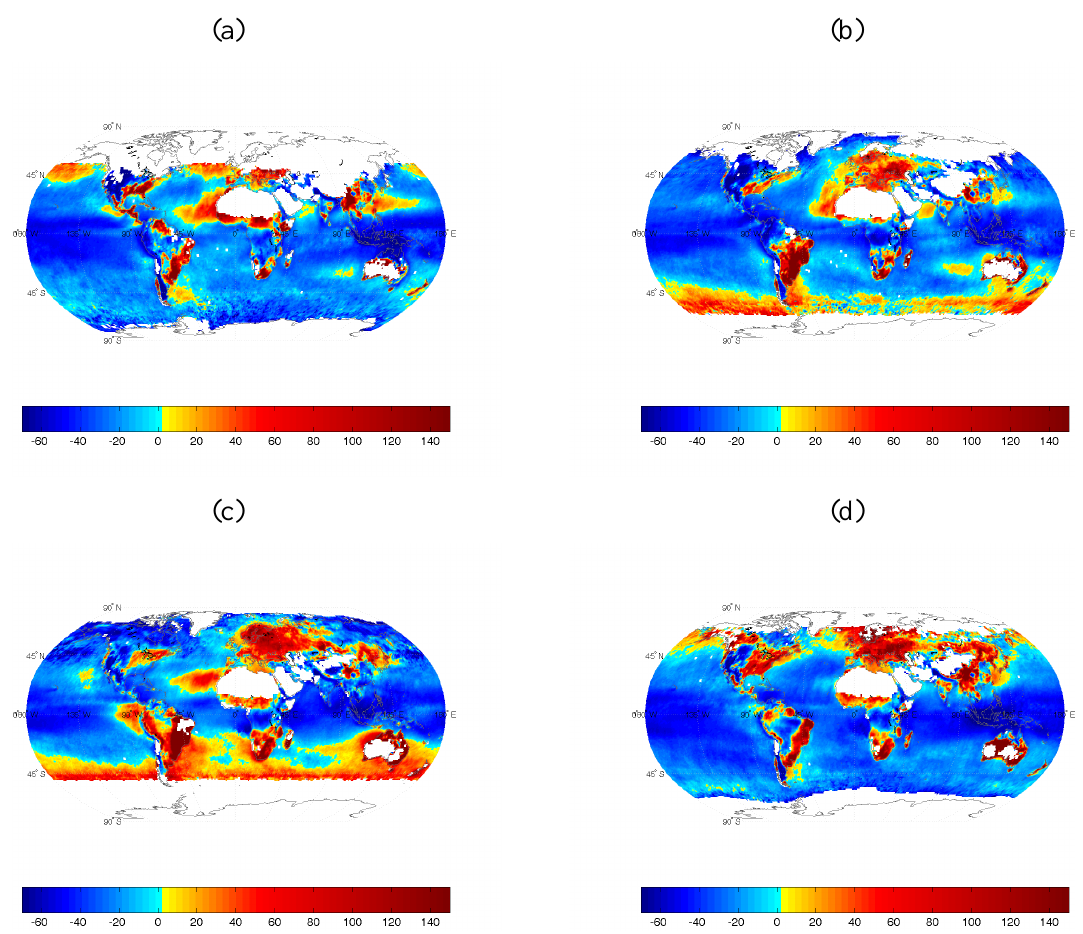
Fig. 2. Comparison between HAC and MODIS (03/2000–02/2007) total aerosol optical depth at 550nm. Global seasonal distribution of relative percentage differences ((HAC − MODIS)/MODIS – %) for (a) winter (DJF), (b) spring (MAM), (c) summer (JJA) and (d) autumn (SON). White shaded areas correspond to cases for which MODIS AOD values are missing or do not qualify for the averaging threshold. The maps are presented on a 1 ◦ × 1 ◦ latitude – longitude